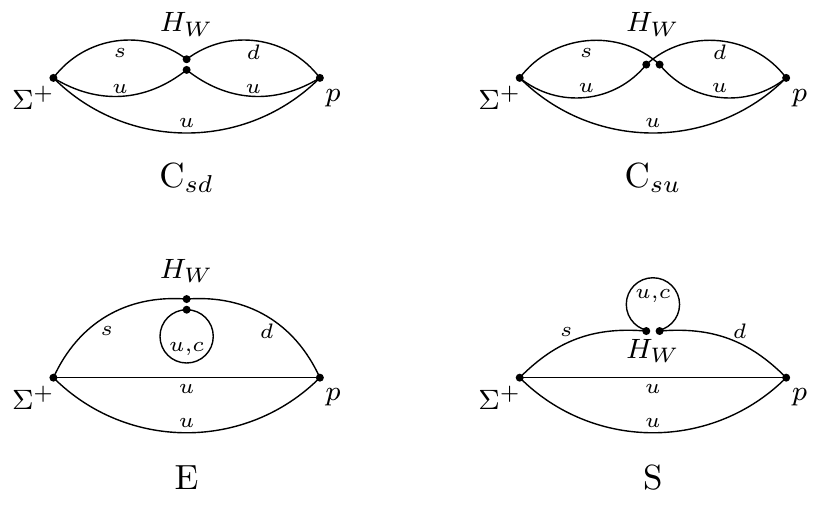
Figure 2 . The four different topologies for the Wick contractions of the three-point function (3.21). Two fully connected contractions C sd and C su and two topologies (E and S) containing quark loops. The two diagrams on the left (C sd and E) arise from contractions using the Q 1 operator, the two diagrams on the right (C su and S) from Q 2